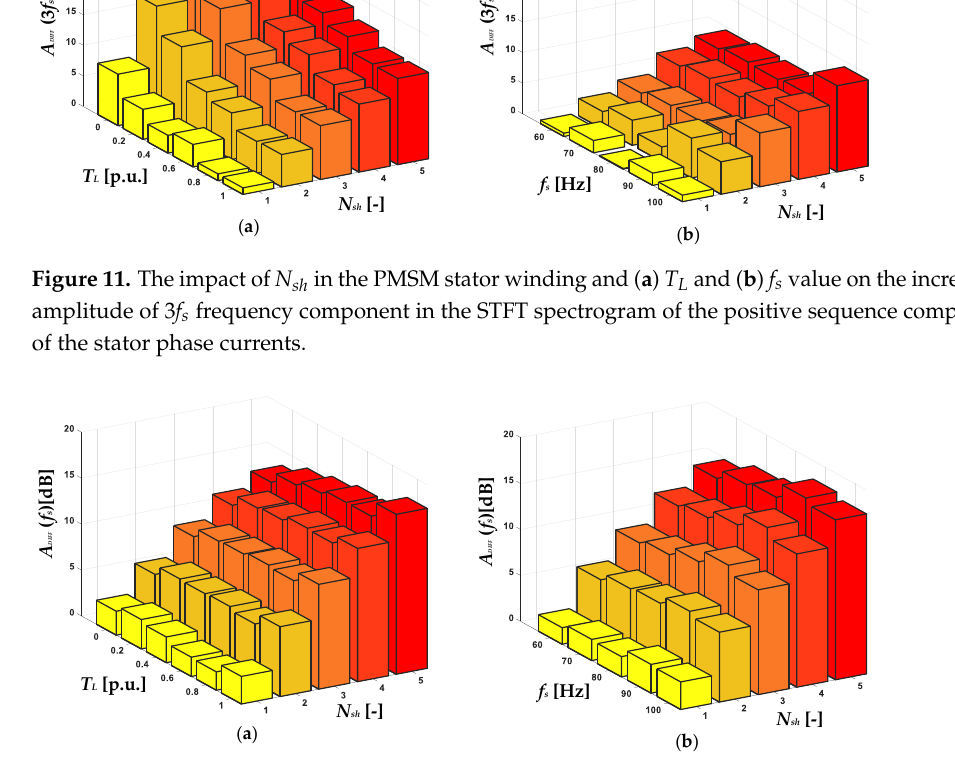
Figure 12. The impact of N sh in the PMSM stator winding and ( a ) T L and ( b ) f s value on the increase in amplitude of f s frequency component in the STFT spectrogram of the negative sequence component of the stator phase currents.